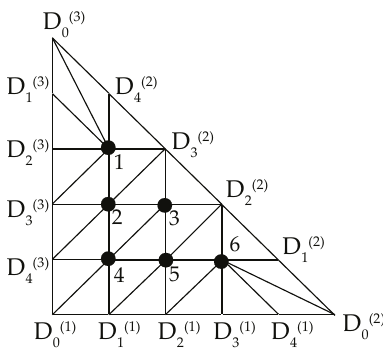
Figure 5 . The labeling of T N singularity, with an example of N =